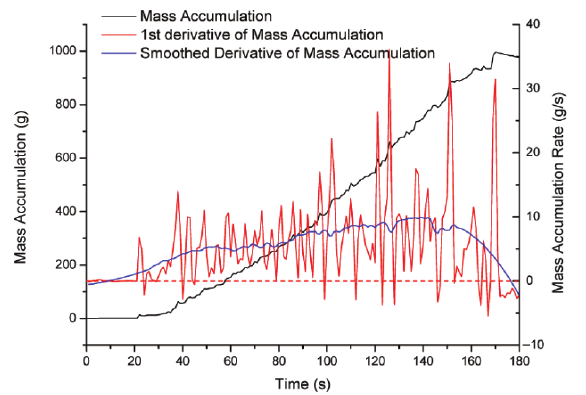
Fig. 9. Statistical results of recognizable droplets under different